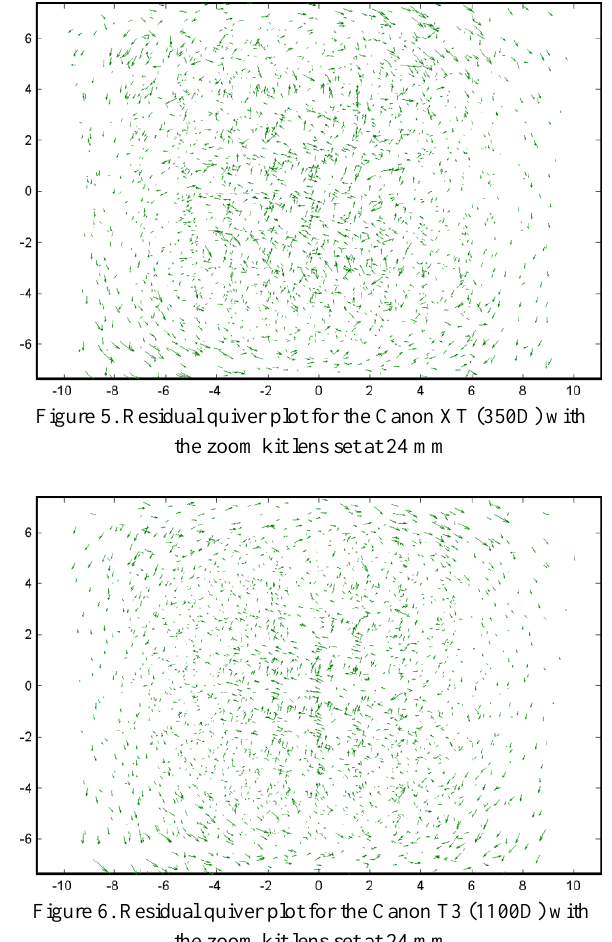
Figure 6. Residual quiver plot for the Canon T3 (1100D) with the zoom kit lens set at 24 mm